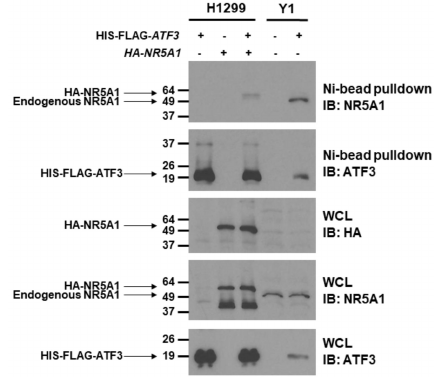
Figure 1. Steroidogenic factor 1 (NR5A1) physically interacts with activating transcription factor 3 (ATF3). H1299 cells were transfected with of HIS-FLAG-tagged ATF3 or HA-tagged NR5A1 or both expression plasmids. Y1 cells were transfected with HIS-FLAG-tagged ATF3 expression plasmid. Forty-eight hours later, the cell lysates were immunoprecipitated by anti-HIS antibody, followed by anti-ATF3 or anti-NR5A1 immunoblotting. WCL indicates whole cell